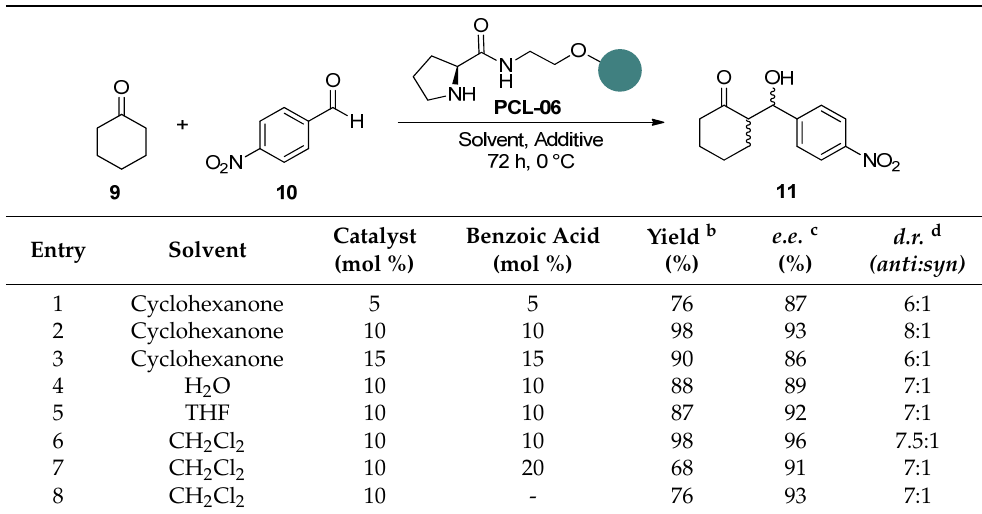
Table 3. Optimization of reaction conditions for application of the supported catalyst PCL-06 in asymmetric aldol addition a .